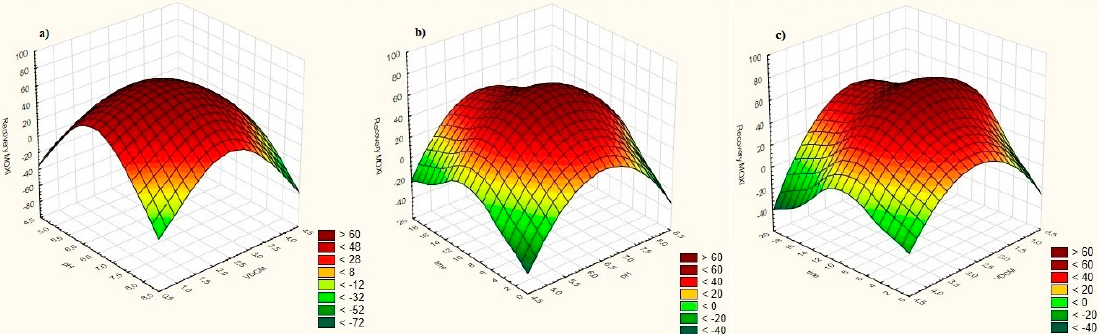
Figure 4. The RSM diagrams illustrating the change of recovery of MOXI when analyzed: ( a ) VDCM and pH; ( b ) time and pH; ( c ) time and VDCM for CCD.